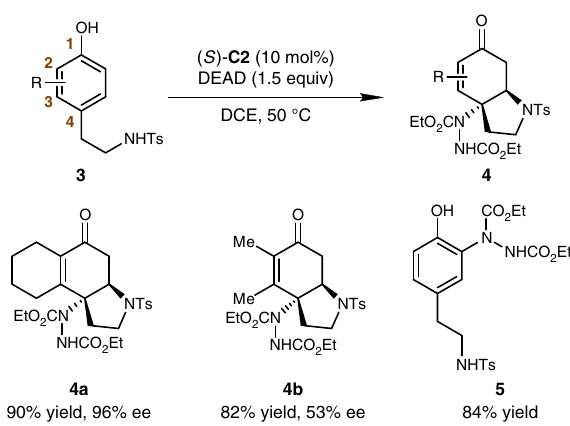
Fig. 3 Substrate Scope of Phenols. Reaction conditions: 3 (0.1 mmol), DEAD (0.15 mmol) and ( S )- C2 (10 mol%) in DCE (2 mL) at 50